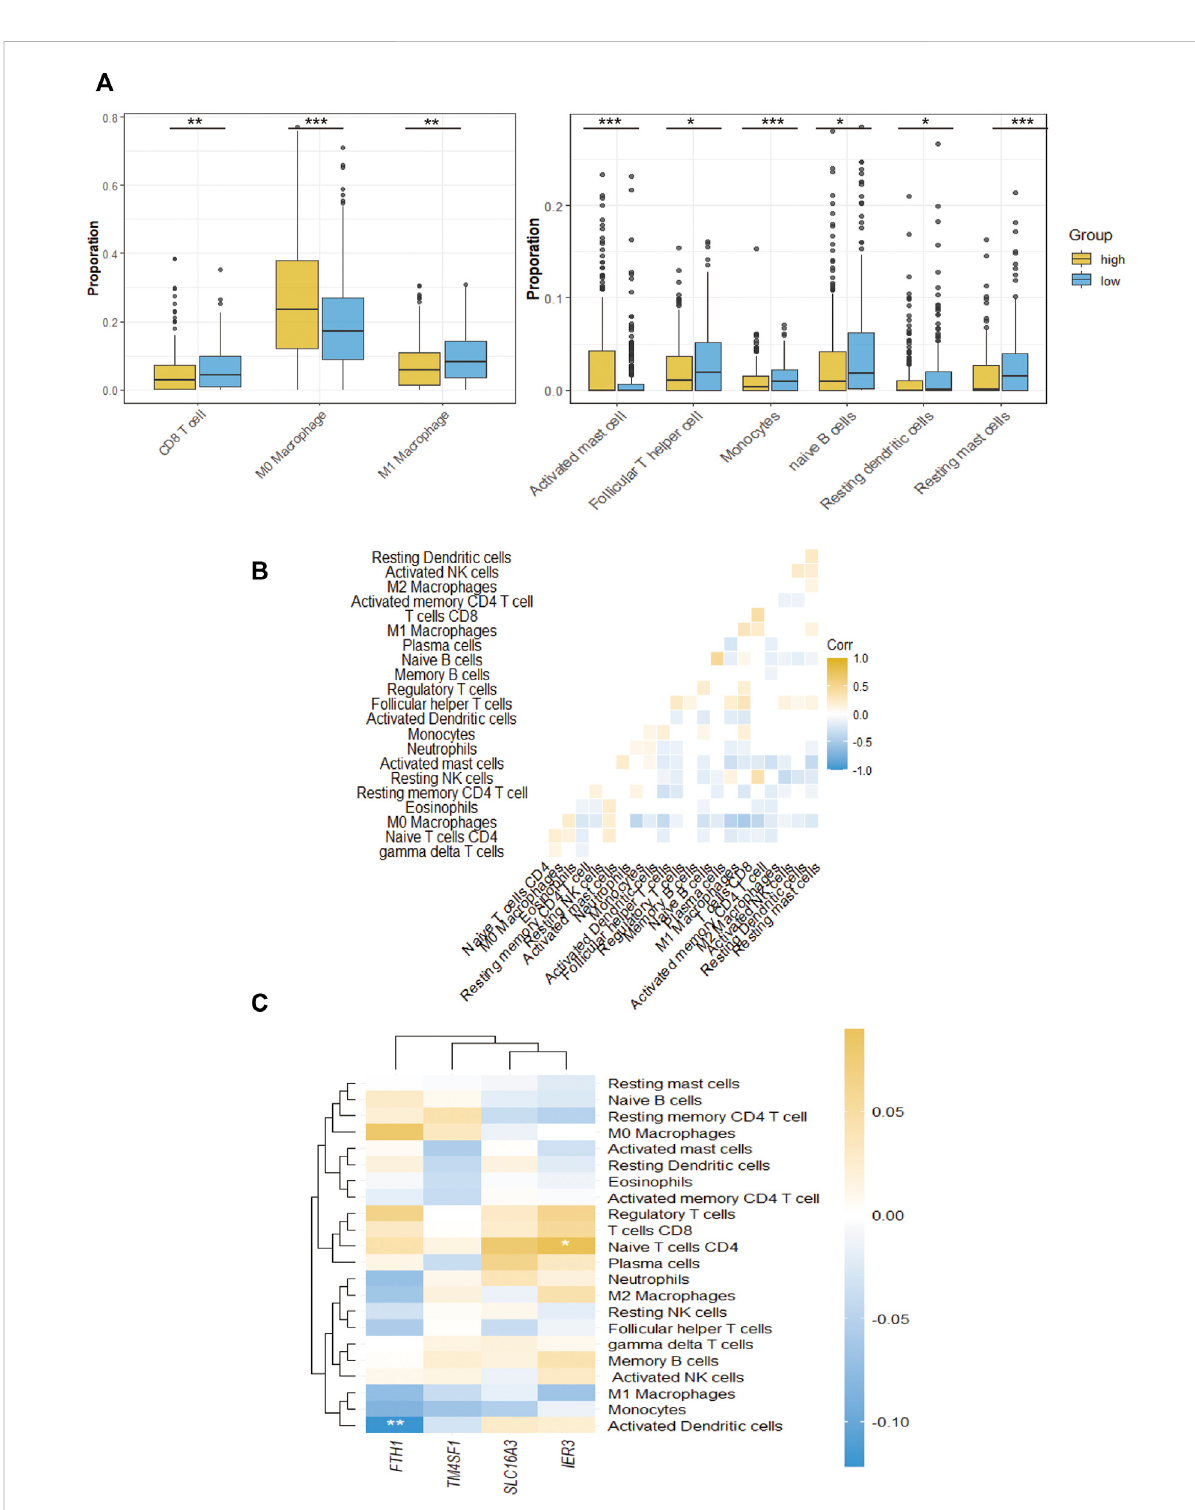
FIGURE 6 The TME immune cell in fi ltration characterization. (A) , The proportions of differently in fi ltrated TME immune cells in two CAF subgroups in TCGA-HNSC cohort. (B) , Correlations between CAF signature genes and different in fi ltrated TME immune cells. (C) , The correlation of